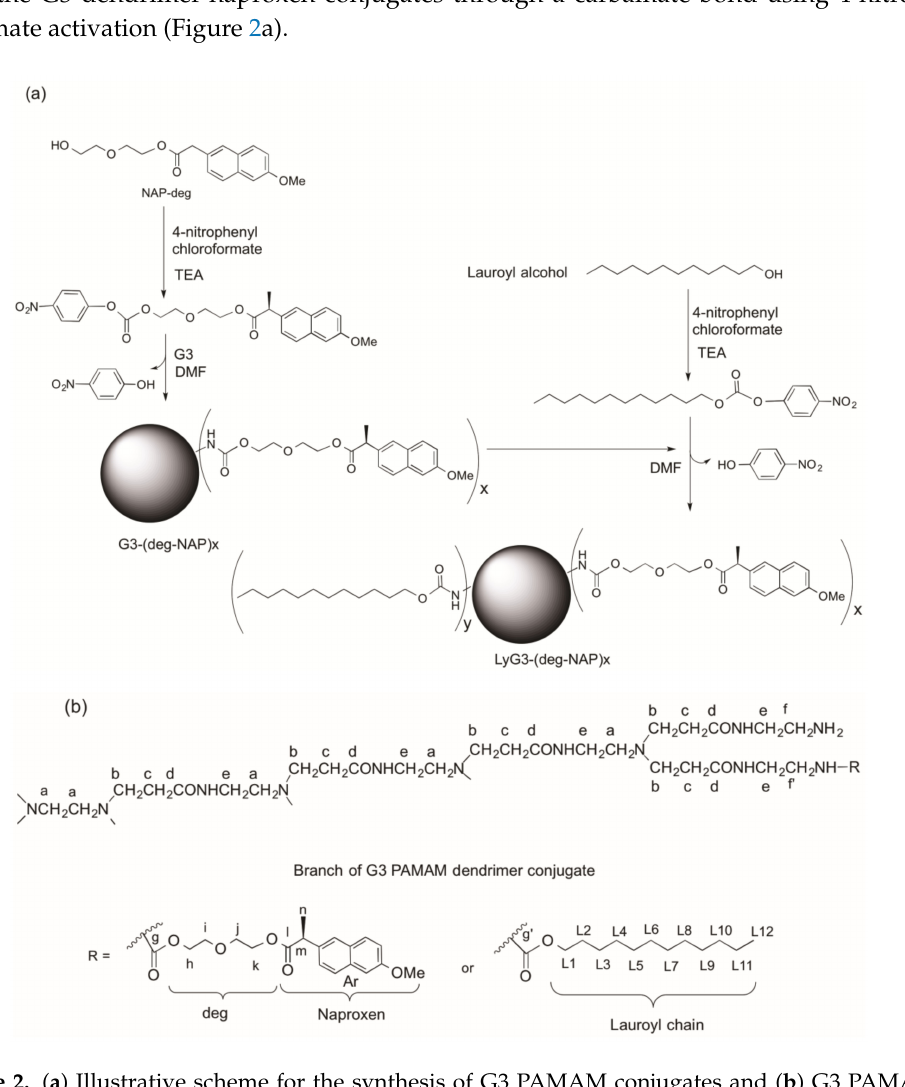
Figure 2. ( a ) Illustrative scheme for the synthesis of G3 PAMAM conjugates and ( b ) G3 PAMAM dendrimer-naproxen conjugates (letters are added to aid 1 H-NMR assignments). G3-(deg-NAP)x and LyG3-(deg-NAP)x were purified by size exclusion chromatography, solubilization in water (NAP-deg and lauroyl alcohol are poorly soluble in water) and dialysis (MW cutoff = 3500 Da) for 48